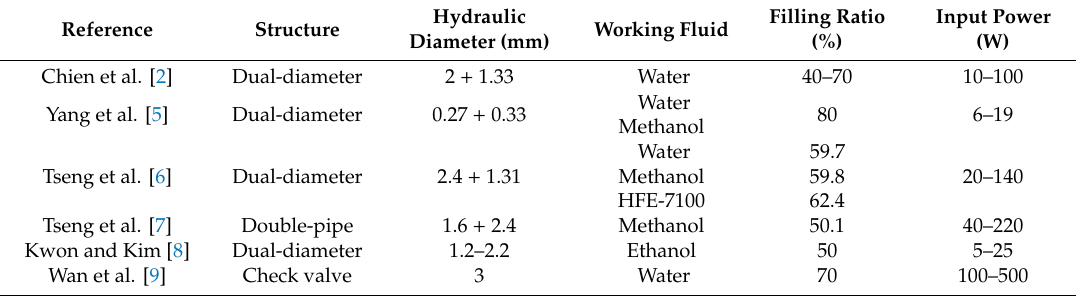
Table 1. Main details of the previous studies in the